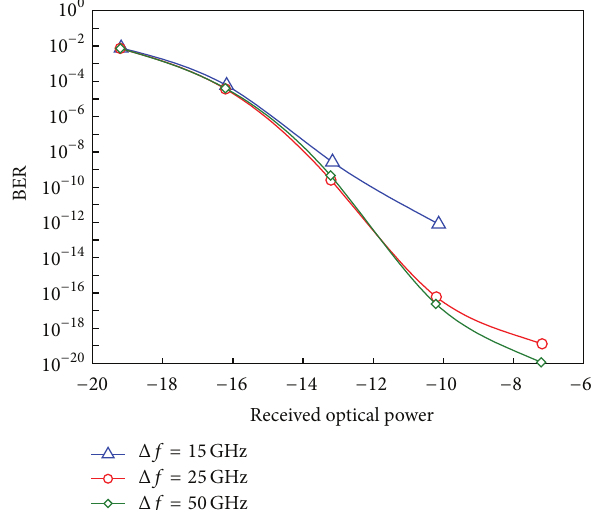
Figure 8: The system performance at different wavelength inter-